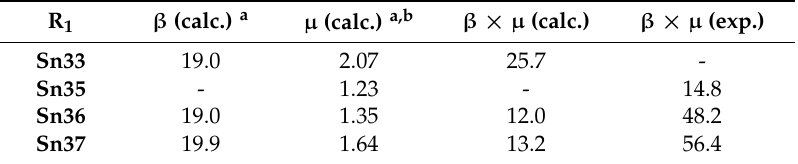
Table 5. Nonlinear optical properties for the hexacoordinated tin